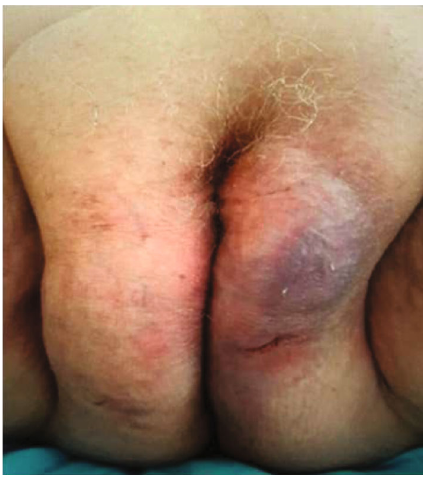
Figure 3: Image of the labia majora after the fi rst session of HBOT. Figure